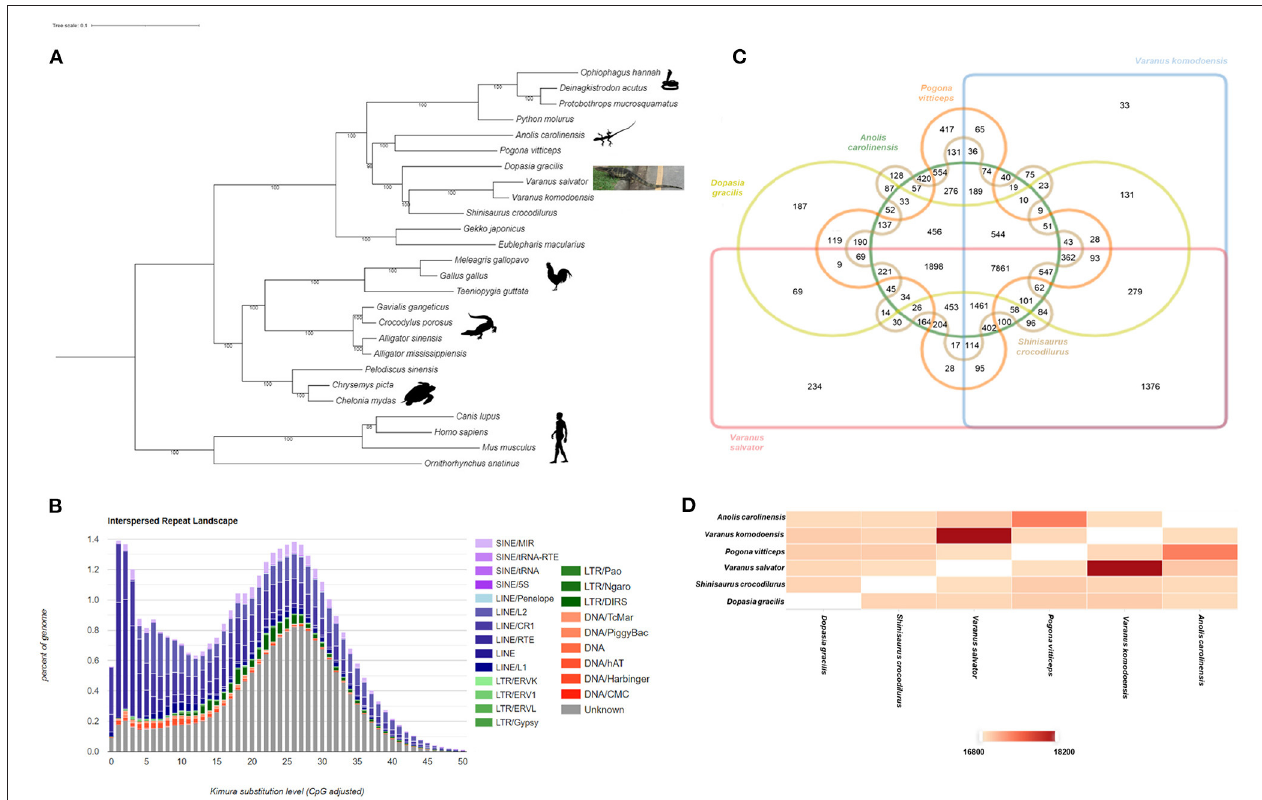
FIGURE 2 | Phylogenetics, Interspersed Repeat Landscape and gene family analysis of V. salvator. (A) Phylogenetic relationships of Varanus salvator with 21 non-avian reptiles and 4 outgroups, inferred by IQ-TREE from 1,339 one-to-one orthologous proteins. Bootstrap values (10,000 pseudoreplicates) are shown at the nodes. All silhouettes reproduced from PhyloPic. Credits: Ophiophagus hannah silhouette, V. Deepak under a Creative Commons license CC BY 3.0. (B) Interspersed Repeat Landscape. The y axis shows the genome percent of each repeat families, the x-axis shows the level of kimura substitution of each repeat families. (C) Venn diagram showing the distribution of gene families (orthologous clusters) among six species including two members of the order Squamata ( A. carolinensis and P. vitticeps ) and four closely related members of the suborder Anguimorpha ( V. salvator , V. komodoensis , S. crocodilurus , D. gracilis ) (D) The heatmap of overlapping cluster numbers of protein that were shared each pair of genomes. Each cell indicates the overlapping cluster numbers between each pair of species.